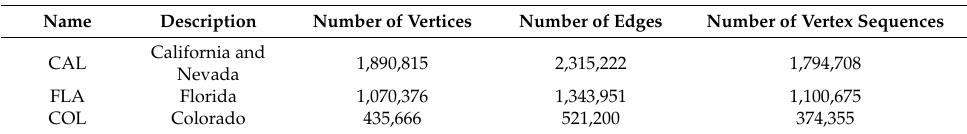
Table 5. Real-world roadmaps.